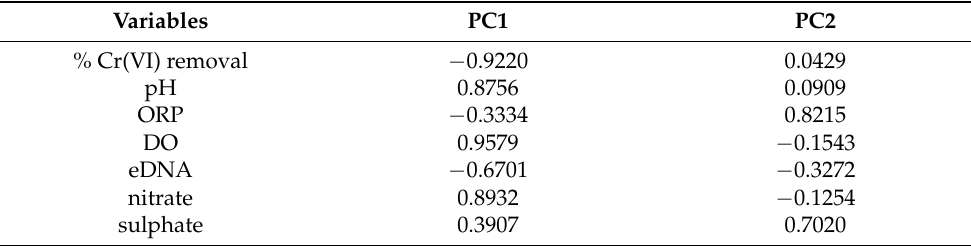
Most variables strongly contribute to PC1, as described by the PCA factor loadings in Table 5. The percentage of Cr(VI) removal ( − 0.9220) and eDNA ( − 0.6701) are negatively related to PC1, while pH (0.8756), DO (0.9579) and nitrate (0.8932) are positively related to PC1. The ORP (0.8215) and sulphate (0.7020) are positively related to PC2. Table 5. Factor loadings of the first two main components of the PCA.